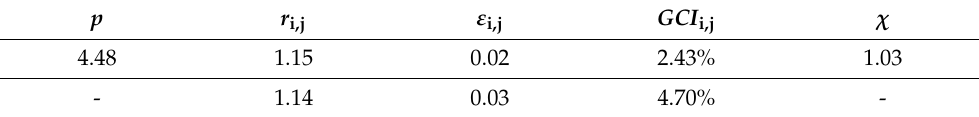
Table 6. Values calculated using GCI